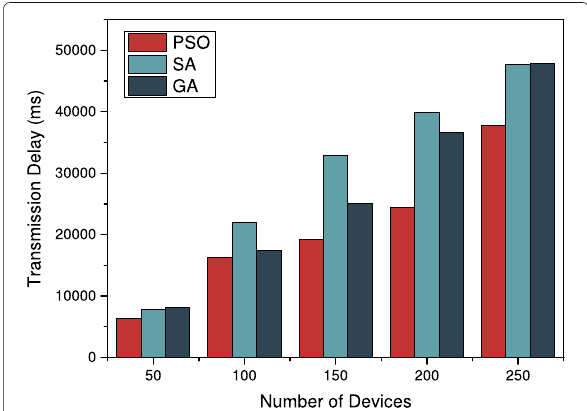
Fig. 8 Comparison of the delays of the three offloading strategies under different numbers of devices